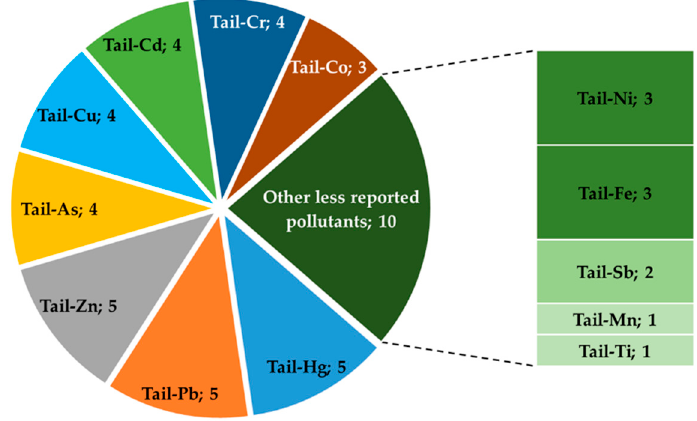
Figure A2. Environmental pollutants measured in mine tailings samples ( n = 7). Note: As, arsenic; Cd, cadmium; Co, cobalt; Cr, chromium; Cu, copper; Fe, iron; Hg, mercury; Mn, manganese; Ni, nickel; Pb, plumb; Sb, antimony; Ti, titanium; and Zn, zinc.